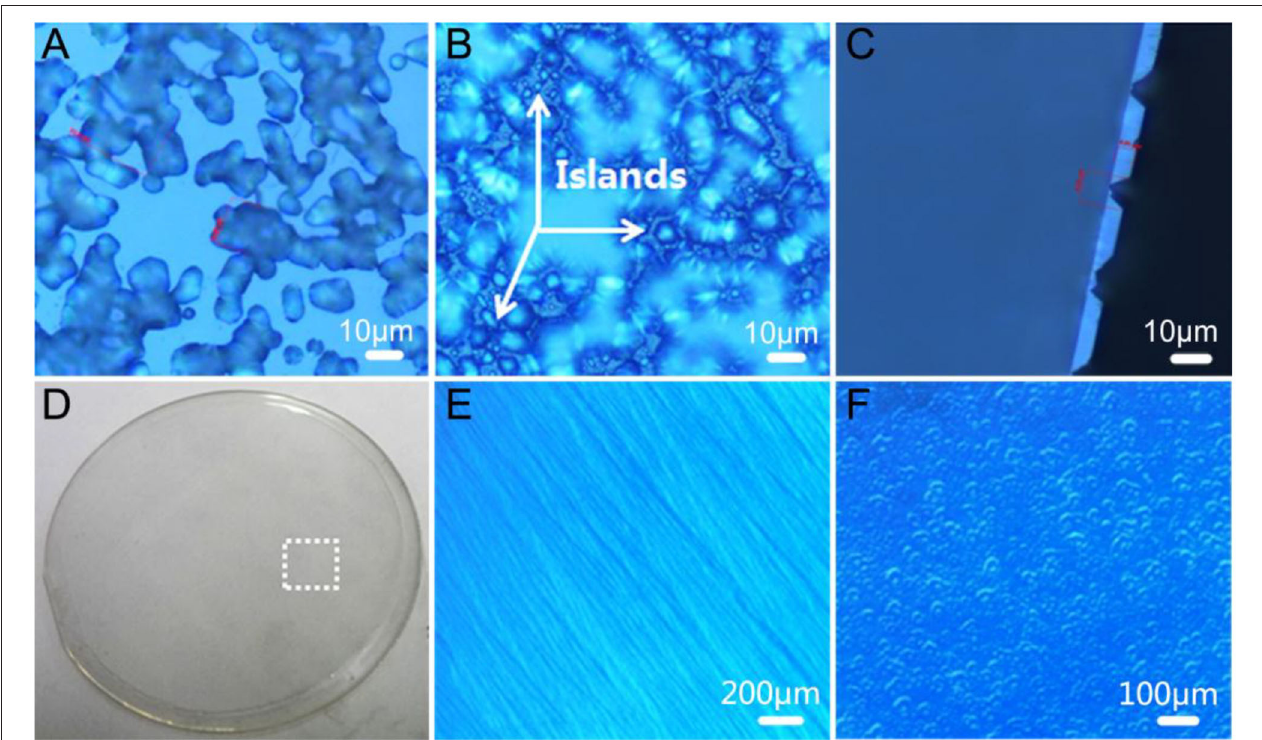
FIGURE 5 | Optical images of the GaN 3D interlayer grown on LT-AlN with annealing pre-treatment focused on the surface (A) and near the interface between the GaN epitaxial layer and the LT-AlN-covered sapphire substrate (B) . (C) Microscopic mage of the cross-section of (A) . (D) Photographic image of sample D. Microscope images of the dotted white rectangle in (D) when focused on surface morphology (E) and near the interface between GaN epitaxial layer and the LT-AlN-covered sapphire substrate (F)